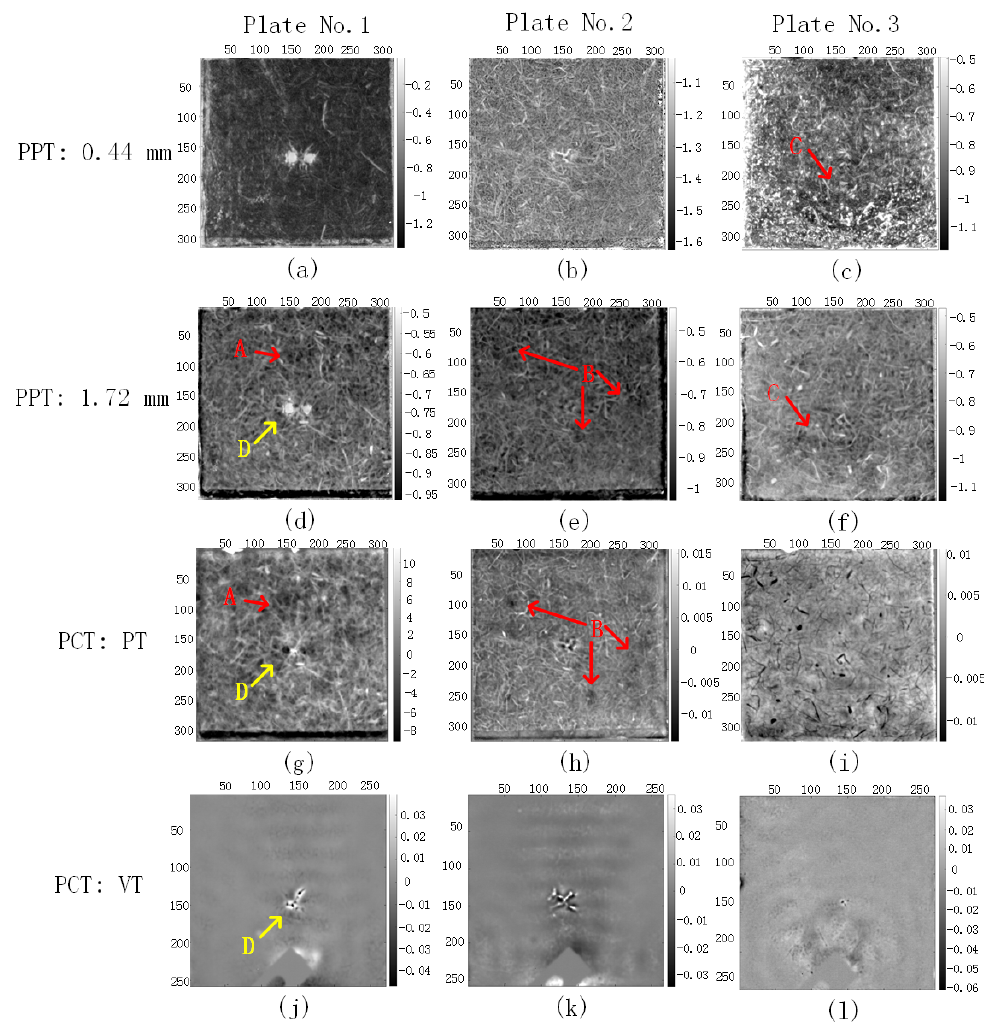
Figure 12. IRT for the jute/hemp fiber hybrid laminates after PPT and PCT